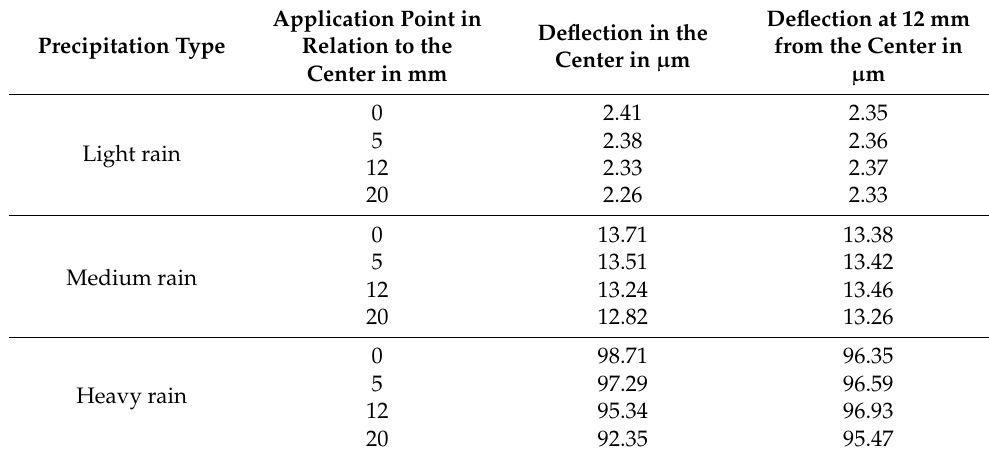
Table 2. Calculated deflection of the plate for various momentum at varying points of application at different